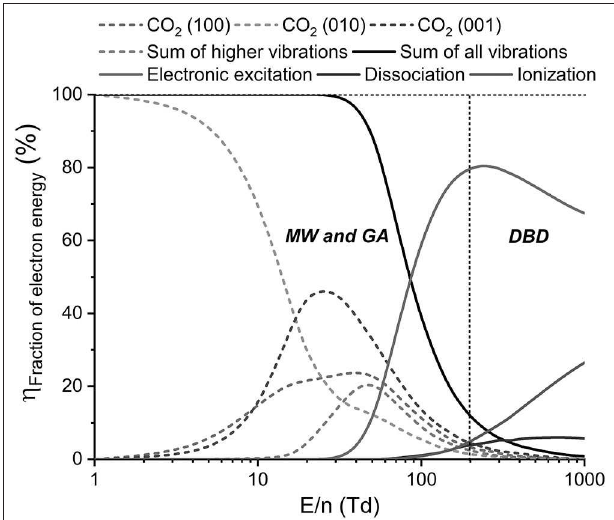
FIGURE 5 | Fraction of electron energy used for different electron impact reactions with CO 2 , i.e., vibrational and electronic excitation, ionization and dissociation, as a function of the reduced electric field (E/n), calculated from the respective cross sections. The E/n regions characteristic for MW and GA plasma and for DBD plasma are indicated. Adopted from Snoeckx and Bogaerts (2017) with permission.